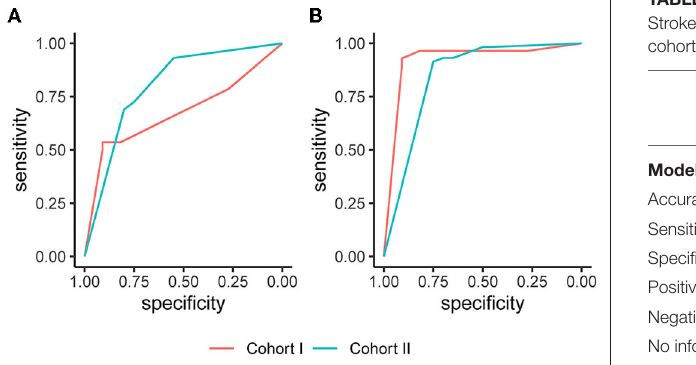
FIGURE 2 | Receiver operating characteristic (ROC) curves based on the imputed datasets. (A) The Early Prediction of Functional Outcome after Stroke (EPOS) model for day 2, measured on day 1 in Cohort I and on day 3 in Cohort II; (B) The EPOS model for day 9, measured on day 8 in Cohort I and day 9 in Cohort II.